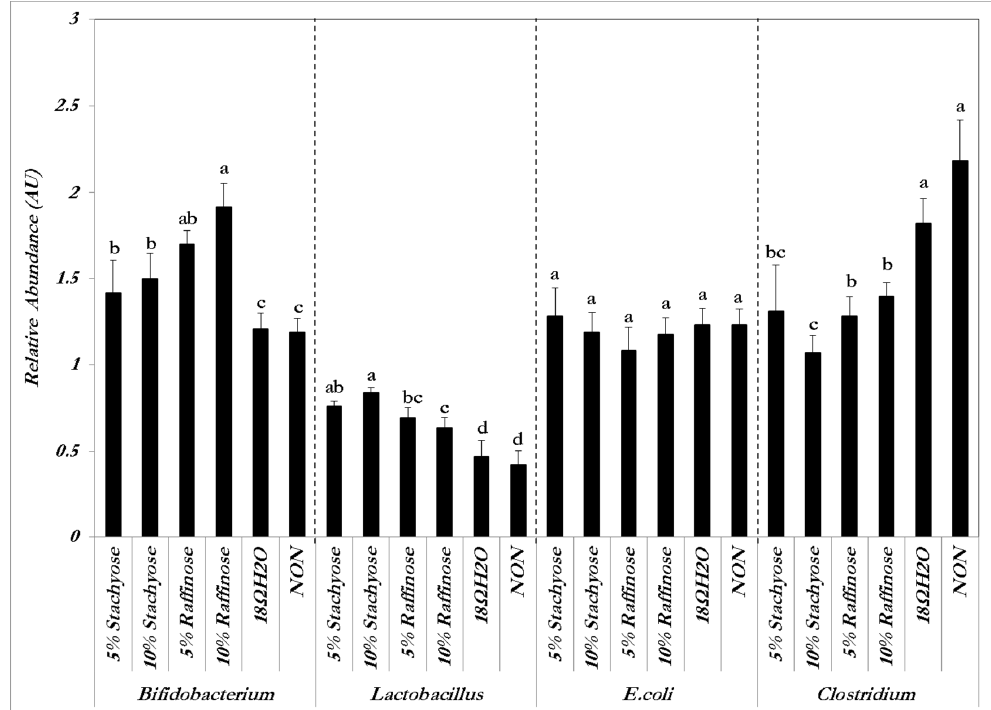
Figure 1. Genera and species ‐ level bacterial populations (AU) from cecal contents measured on the day of hatch. Values are means ± SEM, n = 8. Per bacterial category, treatment groups not indicated by the same letter are significantly different ( p < 0.05).